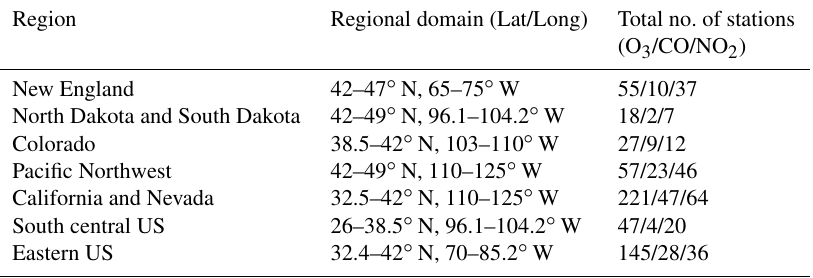
Table 6. Details of the various regions defined for assessing simulated surface concentrations for O 3 , CO and NO 2 using data from the AirNow measurement network. The total number of individual stations for each respective species is given in the rightmost